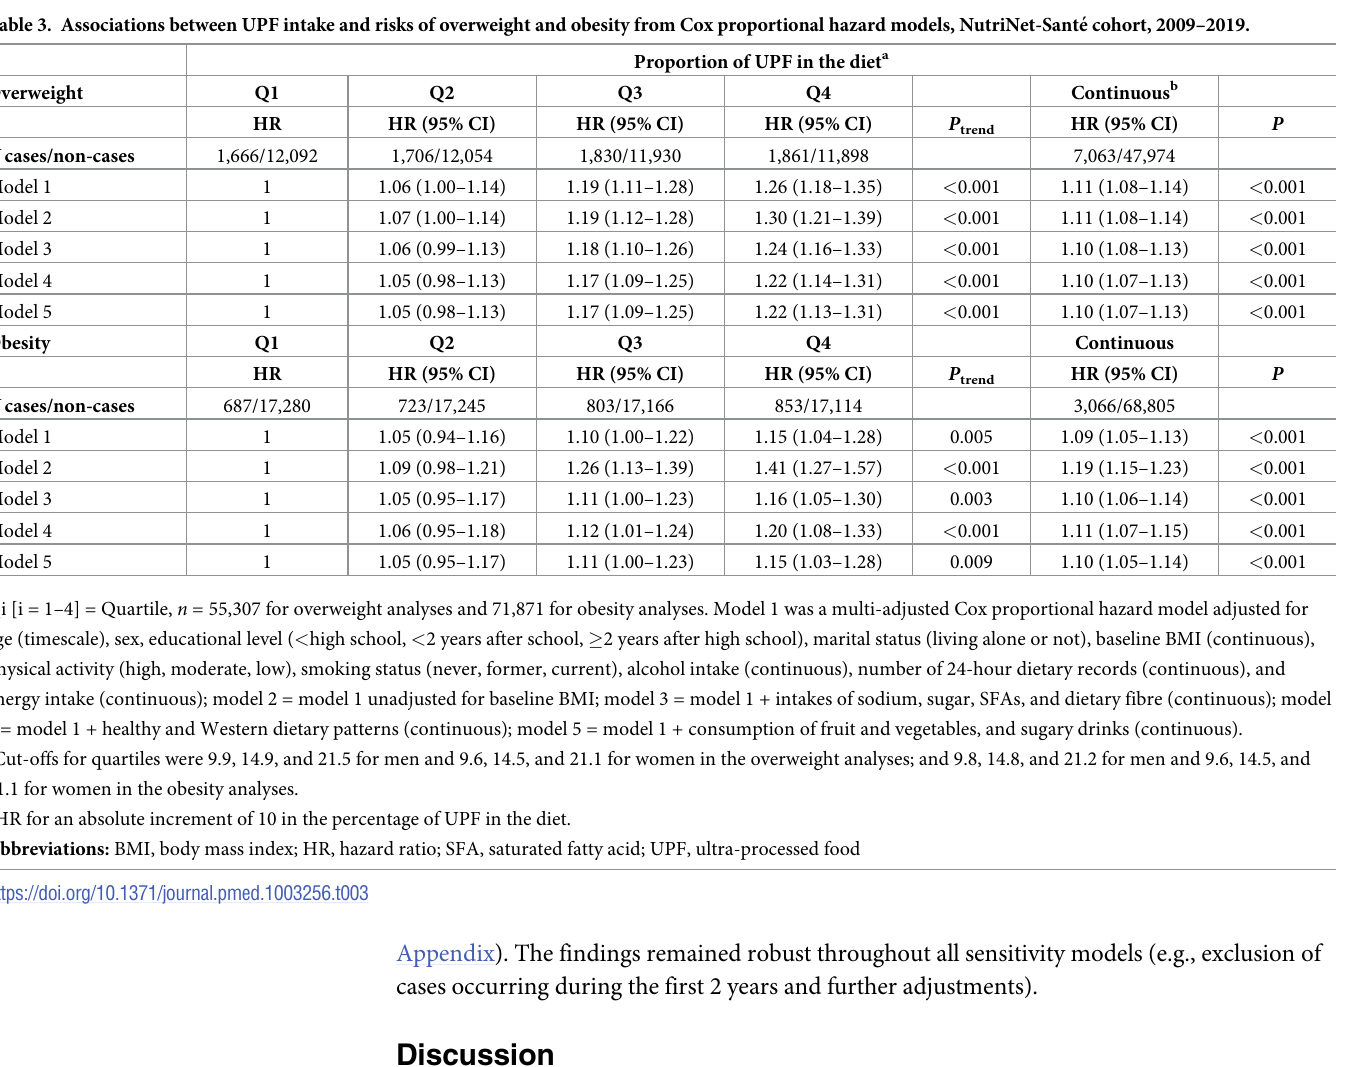
Table 3. Associations between UPF intake and risks of overweight and obesity from Cox proportional hazard models, NutriNet-Sante´ cohort, 2009–2019.